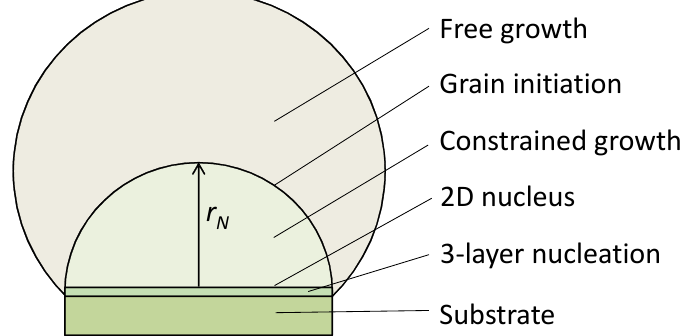
Figure 2. Schematic illustration of early stages of solidification processes on a single substrate. Heterogeneous nucleation through the three-layer nucleation mechanism delivers a 2D nucleus. However, further growth is constrained by the curvature of the liquid/solid interface and can only occur by increasing undercooling. Grain initiation is completed by growing the solid beyond the hemisphere where free growth is possible isothermally.